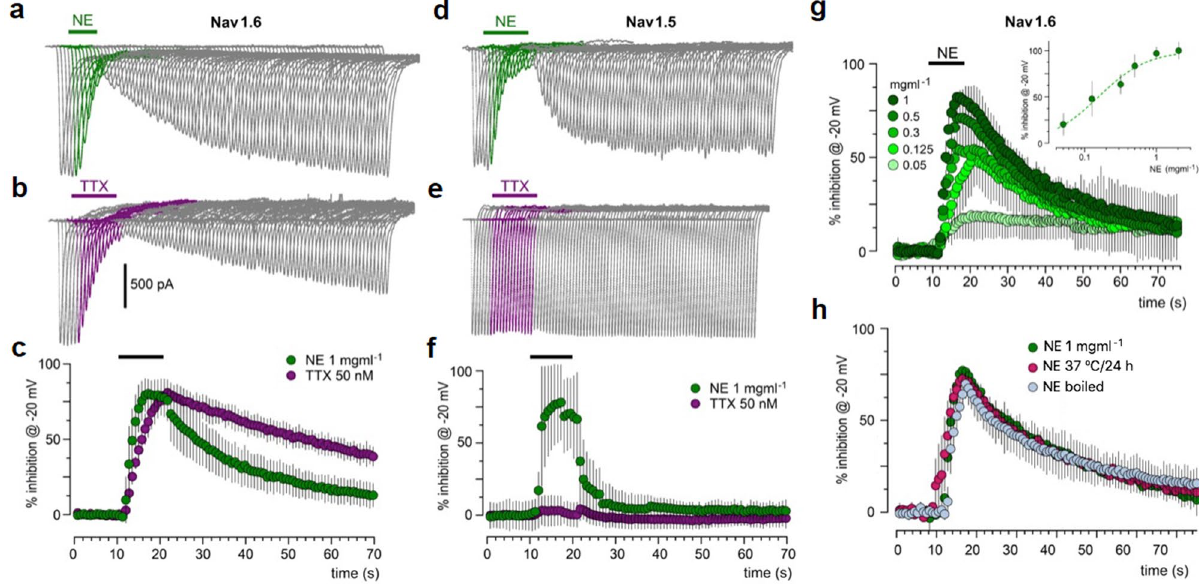
Figure 6. Nematocysts extract (NE) from B. annulata potently inhibited I Nav elicited by opening of hNa v 1.6 and hNa v 1.5. ( a ) HEK293 cells expressing hNa v 1.6 channels were recorded and I Nav was activated applying voltage steps from − 100 to − 20 mV, using a similar protocol to that used in Fig. 3c. In the experiment illustrated, 1 mg ml −1 NE was applied as indicated by the bar in green after a control recording of I Nav (traces in gray); during NE superfusion I Nav decreased progressively (traces in green) and recovered during wash. ( b ) Traces show the effect of 50 nM TTX (purple traces) using the same protocol in cells from the same cultures. The graph in ( c ) shows the time-course of the inhibitory effect produced by each treatment (mean ± S.D. from 6 to 10 cells). ( d,e ) HEK293 cells expressing hNa v 1.5 channels were recorded in similar manner and tested for either NE (traces in green) or TTX (traces in purple); as expected TTX did not affect I Nav , but NE strongly inhibited the response. The inhibition time-course produced by NE is illustrated in ( f ) together with the lack of effect by TTX; individual data points are the mean ± S.D. (5 cells in each case). ( g ) A dose–response relationship was built for the NE effect on the I Nav in cells expressing hNa v 1.6 channels (top graph); distinct NE concentrations from 1 to 0.05 mg ml −1 were applied to 6 different cells. Individual data points are the mean ± S.D. of the effect. Then, the normalized peak inhibition for each concentration was plotted (insert graph) and data points were fitted to a dose–response curve (green dashed line, EC 50 = 155 ± 34 μg ml −1 ). ( h ) The graph shows the time-course of I Nav inhibition produced by 1 mg ml −1 NE (green circles), and the effect produced by NE from the same batch that was boiled by 15 min (light blue circles) or NE samples that were incubated at 37 °C overnight (pink circles); individual data points are the mean ± S.D. from 5 cells in each